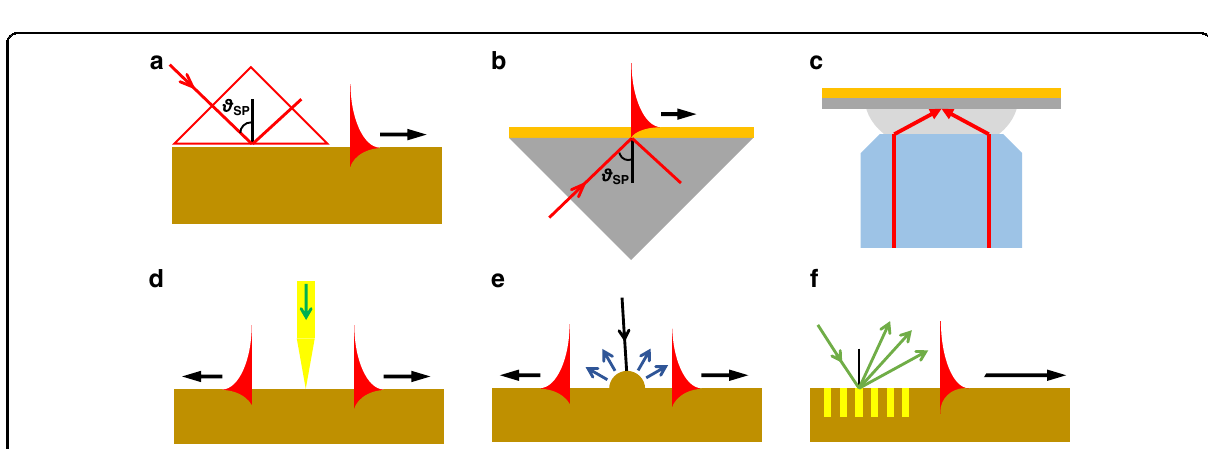
Fig. 2 Con fi gurations for SPP excitation. a Otto geometry, b Kretschmann geometry, c focused excitation with a high-NA objective lens, d excitation with a probe, e diffraction on a surface structure and f diffraction on a